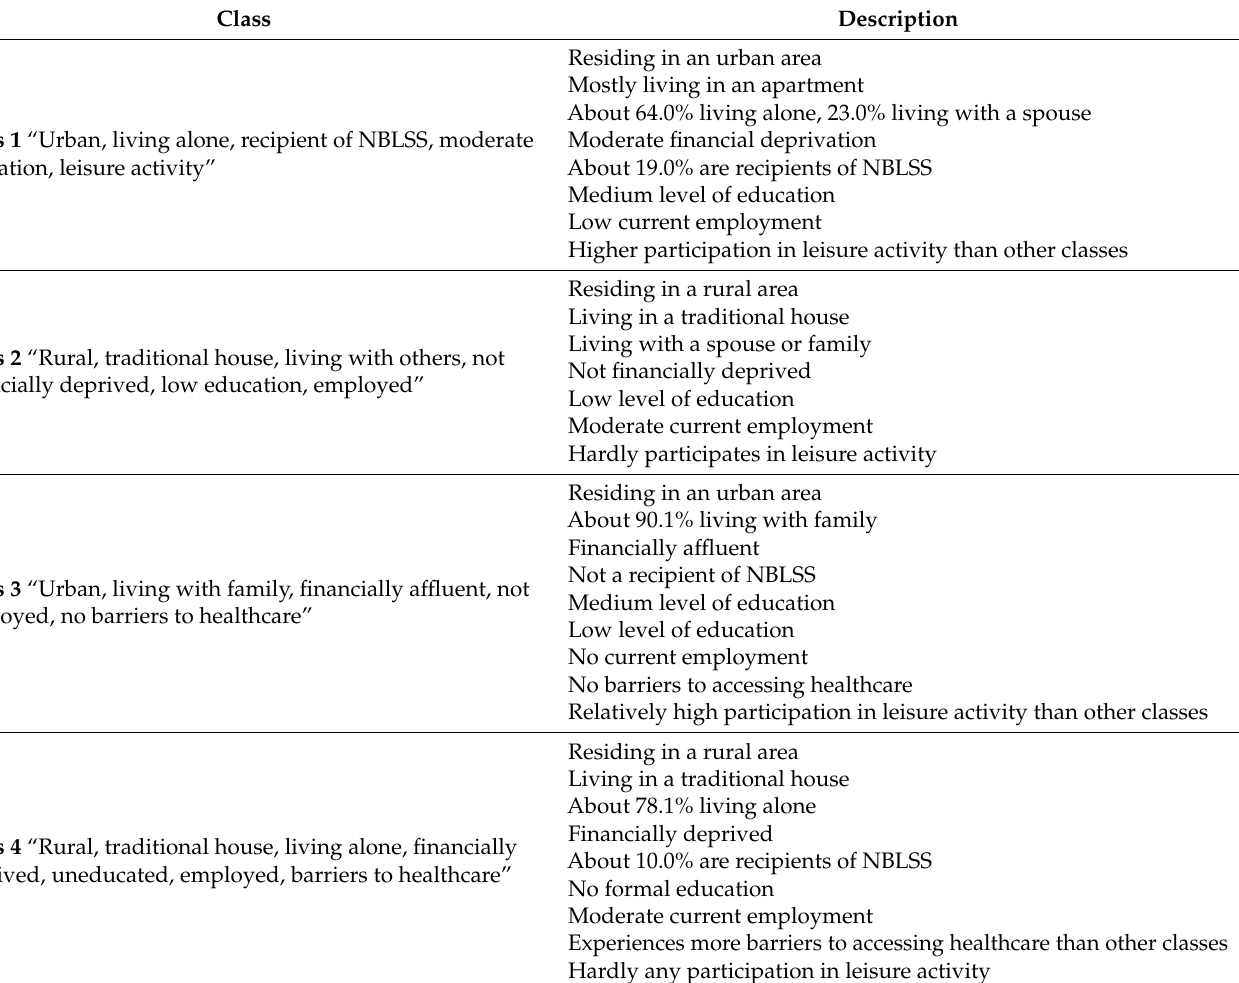
Table 3. Description of latent classes from 4-class model solution for